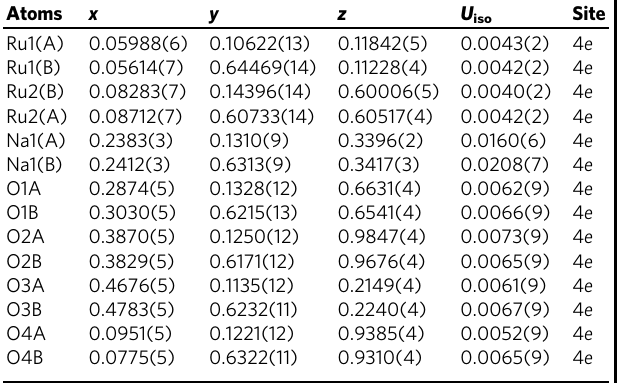
The experimental structural result at room temperature has been determined by twin analysis (with twin (0.43748)) using the Shelx program 20 . The P112 1 / a symmetry is used for the re fi nement as obtained from CBED experiments. The reliable parameters of re fi nement are found to be: wR 2 = 0.0821, R 1 = 0.0344, GoF = S = 1.162: a = 99.256(1)Å, b = 5.634(1)Å, and c = 11.154(1)Å; γ = 90.10 (1)°; volume = 581.7(1)Å 3 . All the atoms in NaRu 2 O 4 crystal-lattice are at 4 e